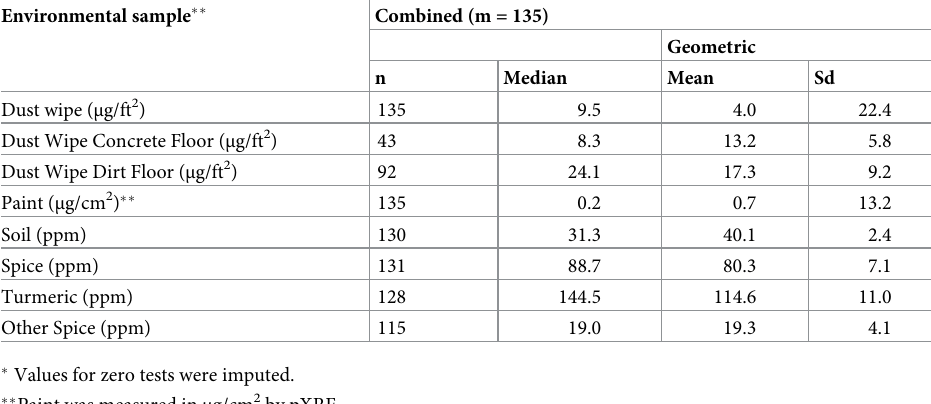
Table 2. Lead levels in household environmental samples for all enrolled children, Patna, Bihar, February 2020.